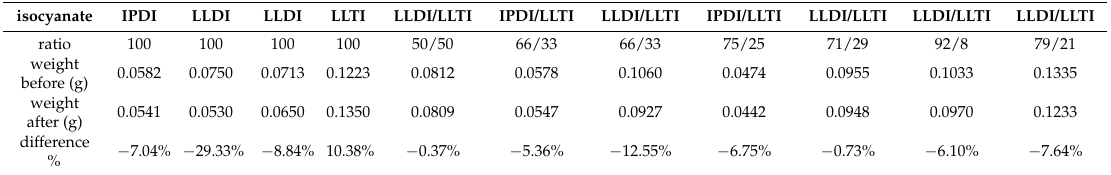
Table 2. Weight loss of different ethyl ester polyurethanes (PU) samples after immersion in DMSO for 1d.